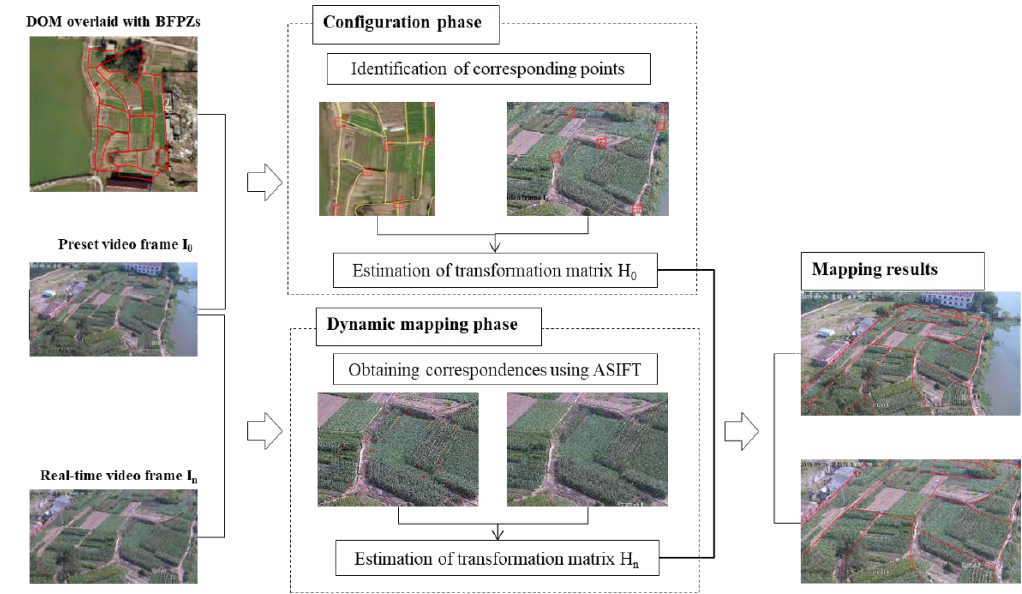
Figure 1. The flowchart of the proposed integration of 2D GIS data and PTZ (pan-tilt-zoom) surveillance video.